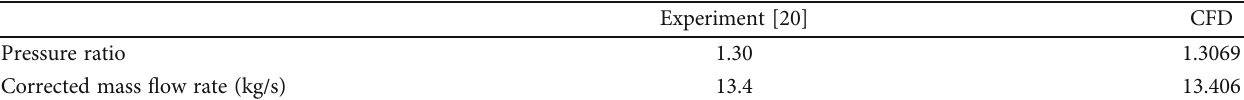
Figure 4: y + of the blade surface. Table 2: Comparison of numerical simulation and experimental results.